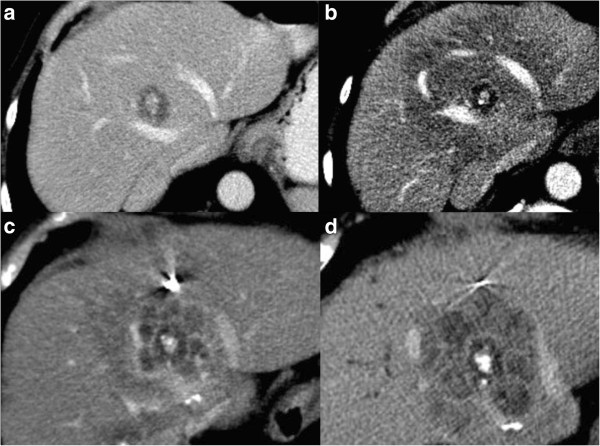
Progressive lesion after SBRT; a liver metastasis with a calcified center before treatment (a), 2 months later (b) we observe the changes of the initial phase as described, 4 months (c) and 6 months later (d) CT slices show the Daisy Sign: a lobulated thick peripheral enhancement.